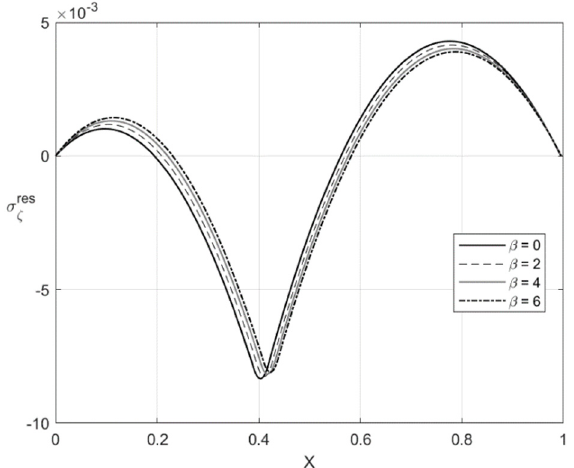
σ 0.06 H r = res σ 0.06 H r = res at , ζ CD at , ζ CD